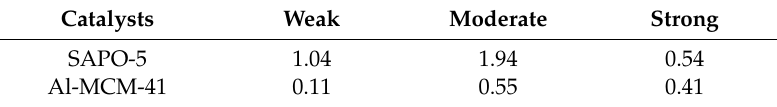
Table 1. Concentration ( × 10 − 2 mmol / g) of SAPO-5 and Al-MCM-41 acid sites.